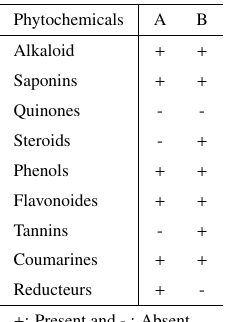
Table 2. Qualitative analysis of phytochemicals in fresh (A) and decaying (B) macrophytes. Phytochemicals